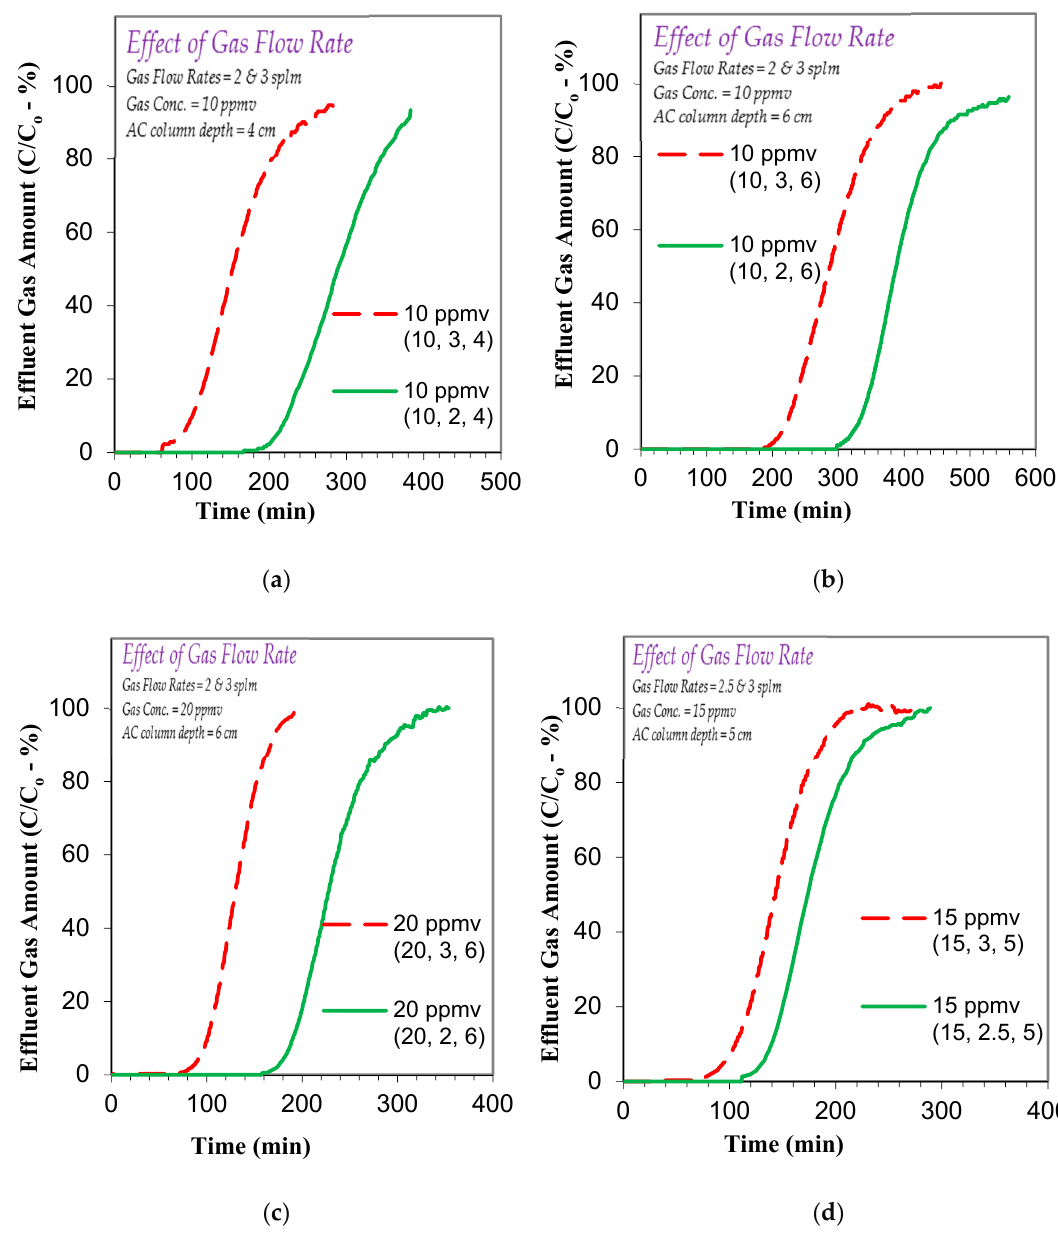
Figure 4. Effect of influent toluene/C 6 H 5 CH 3 gas flow rate on the adsorption breakthrough curve profile of toluene/C 6 H 5 CH 3 gas using AC produced from date palm-tree branches ( a ) toluene/C 6 H 5 CH 3 gas flow rate flow rates = 2 and 3 slpm; influent gas concentration 10 ppmv; AC bed depth = 4 cm; ( b ) toluene / C 6 H 5 CH 3 gas flow rate flow rates = 2 and 3 slpm; influent gas concentration 10 ppmv; AC bed depth = 6 cm; ( c ) toluene / C 6 H 5 CH 3 gas flow rate flow rates = 2 and 3 slpm; influent gas concentration 20 ppmv; AC bed depth = 6 cm; ( d ) toluene / C 6 H 5 CH 3 gas flow rate flow rates = 2.5